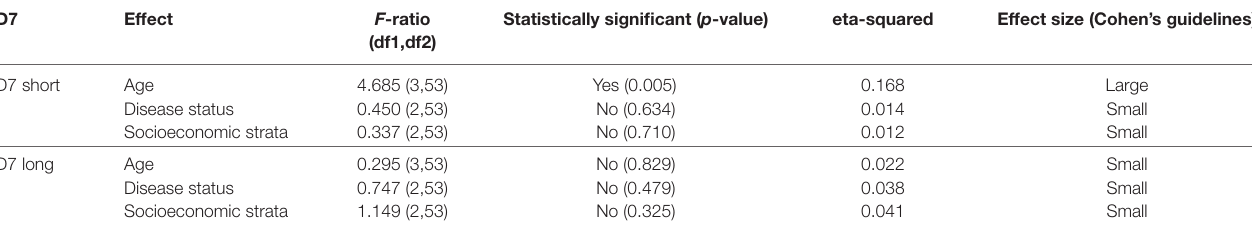
TaBle 1 | Analysis of variance table showing the test statistics F -ratio, statistical significance with α = 0.05, and effect size reported for each variable (age, disease status, and living conditions) evaluated in D7 short and D7 Long for the total sample size ( n = 63 participants).